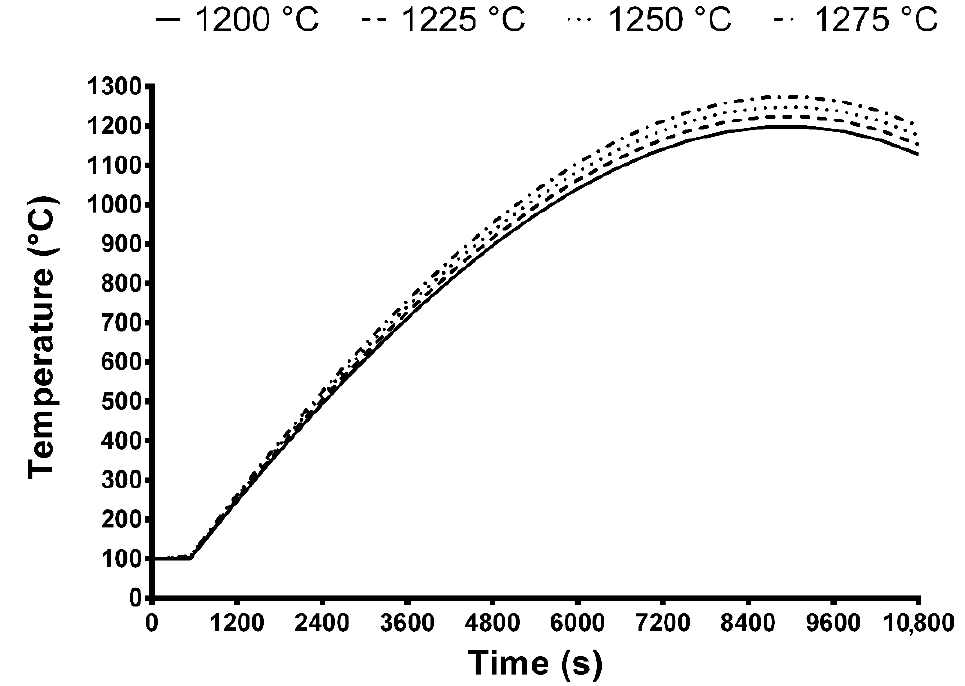
Figure 2. TG furnace heating curves.